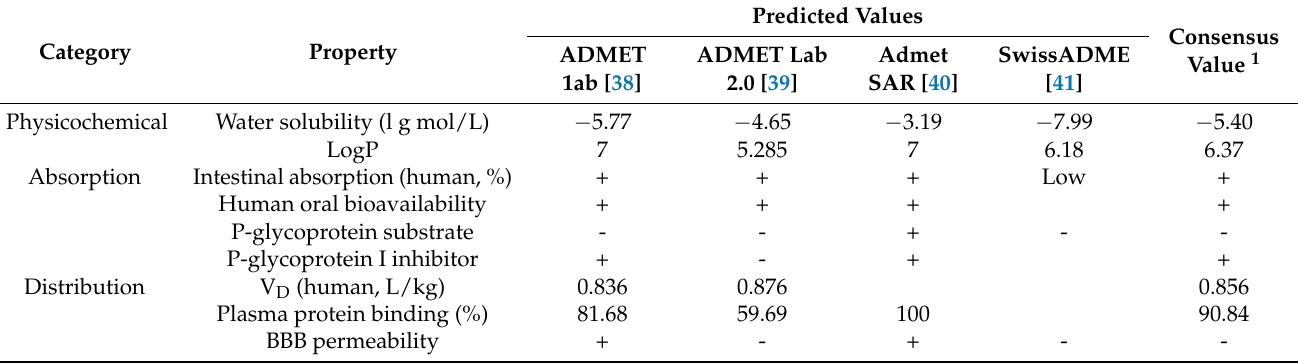
Table 3. Predicted ADMET characteristics of compound 2i